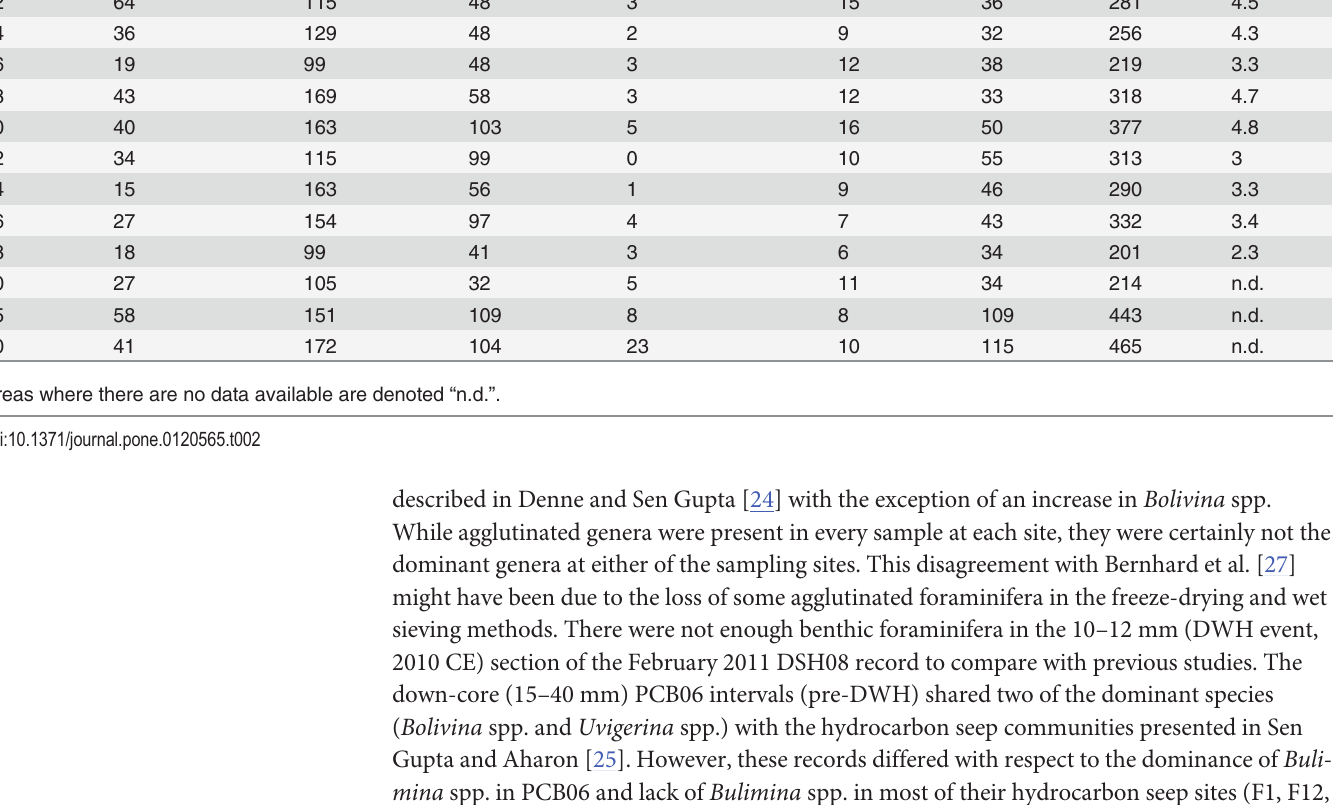
There was no decline in benthic foraminiferal density at the NT1200 control site (Fig. 5, Table 2). However, a decline (i.e. a continuous decrease below down-core mean) was evident in benthic foraminiferal density (all genera, infaunal and epifaunal) and BFAR in the surficial